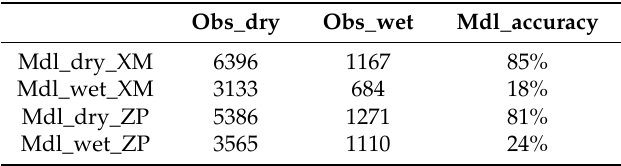
Table 2. Rainfall occurrence (Xiamen (XM) and Zhangping (ZP)), Weather Research Forecast (WRF) outputs during 2010–2015. Obs/Mdl_dry means no rainfall in observation/model.